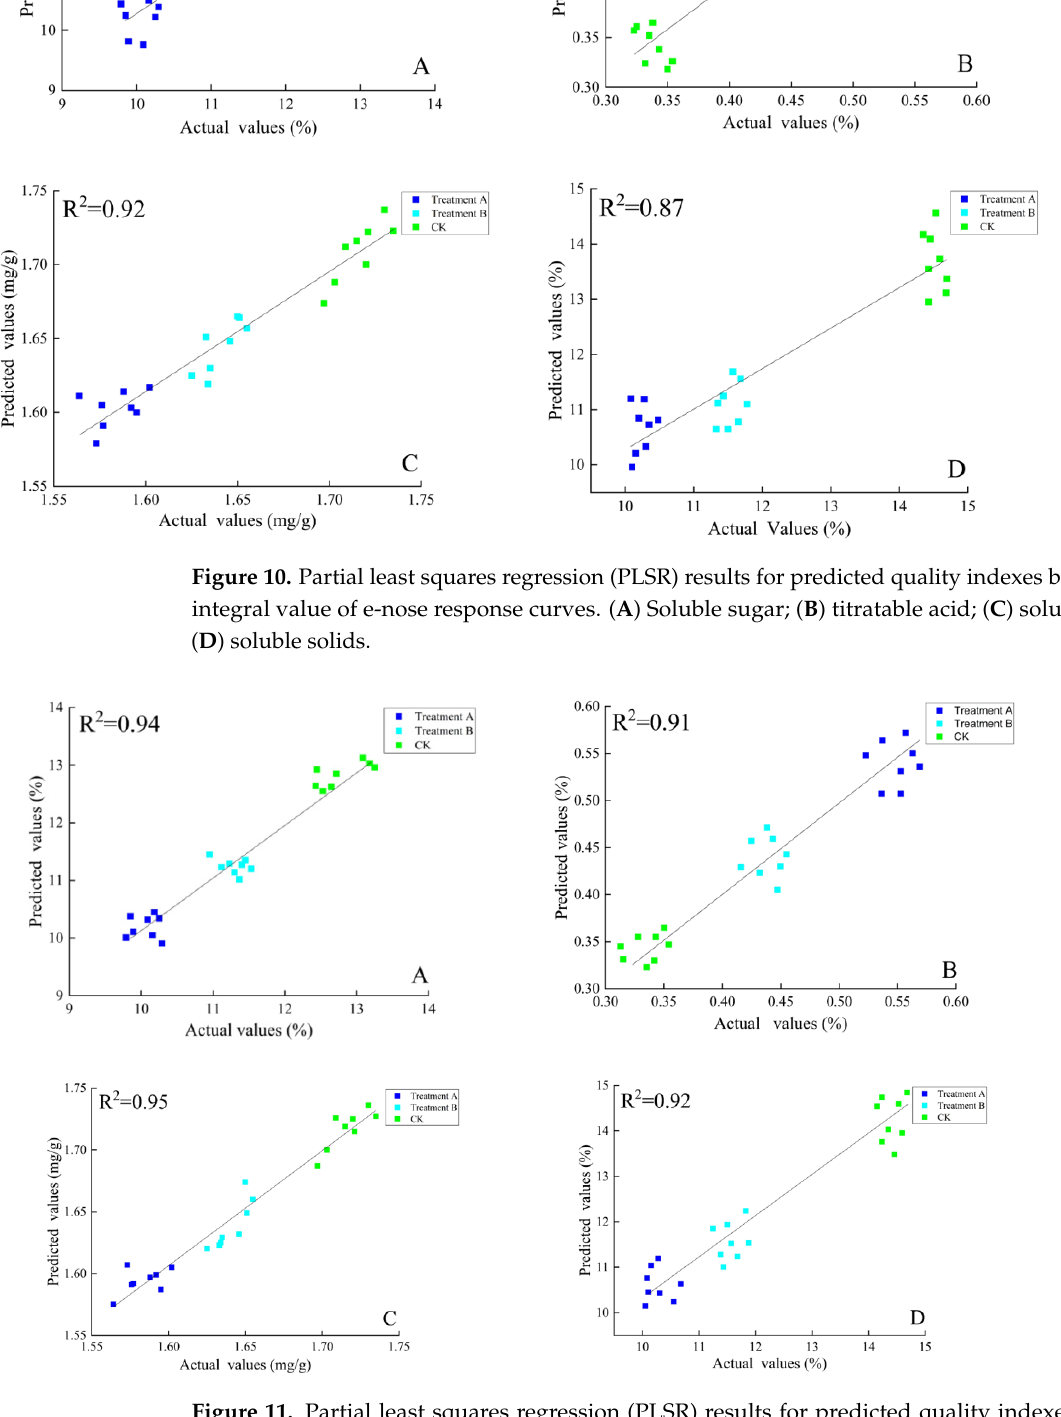
Figure 11. Partial least squares regression (PLSR) results for predicted quality indexes based on the feature value extracted by wavelet transform. ( A ) Soluble sugar; ( B ) titratable acid; ( C ) soluble protein; ( D ) soluble solids.